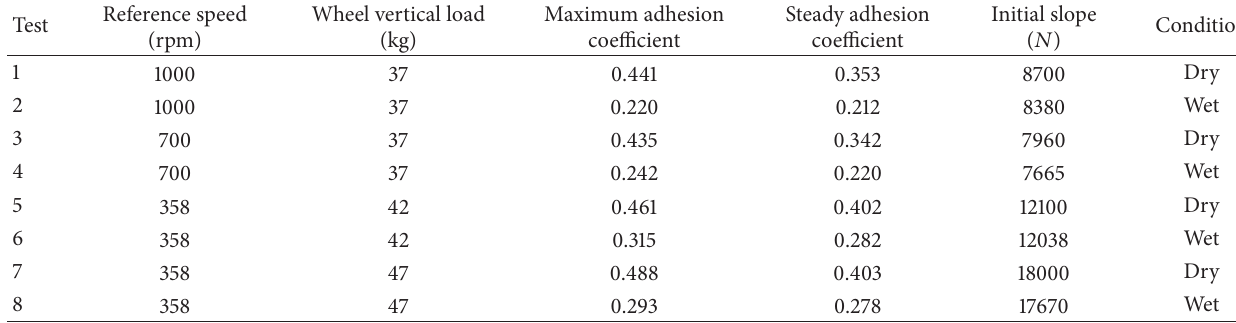
Table 6: Adhesion tests performed and